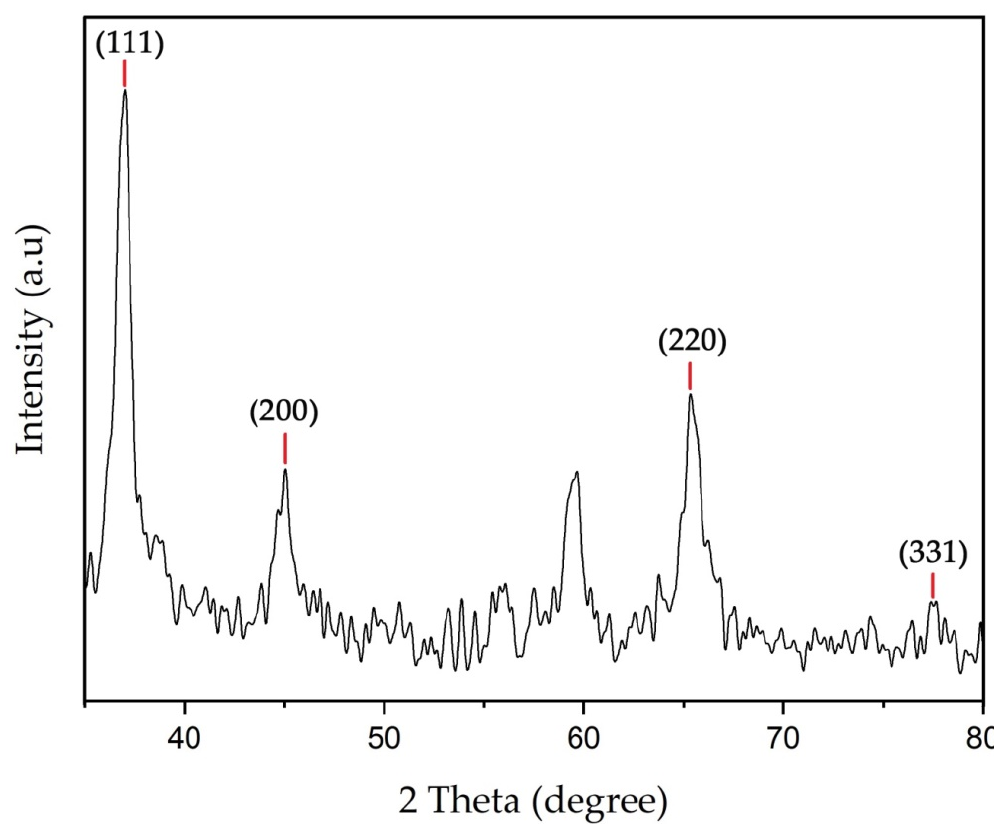
Figure 12. XRD pattern of the CS-coated GNS.